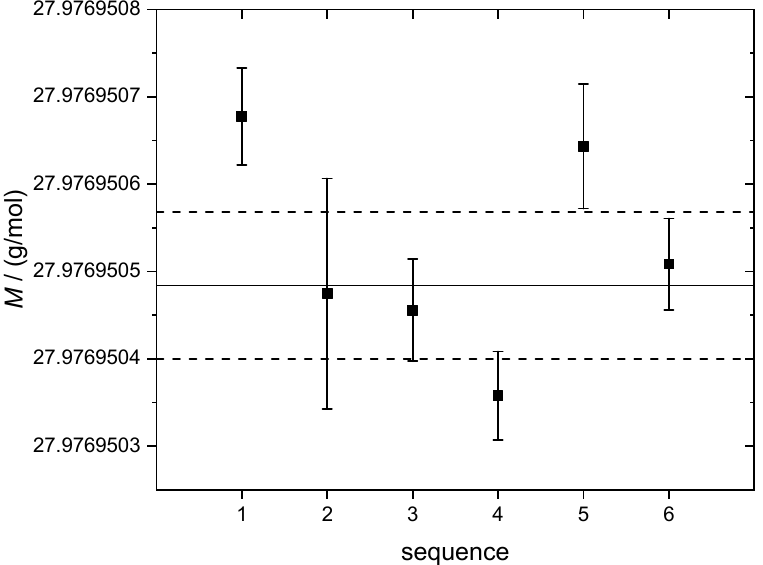
Figure 4. Single measurements of molar masses M of the sample Si28-33Pr11 part V.2.3 (error bars for k = 1 without scattering contribution). The solid line represents the average molar mass M of all sequences (including the measurements of all the other samples). The dashed lines denote the respective upper and lower average uncertainties ( k = 1) without the contribution of scattering.